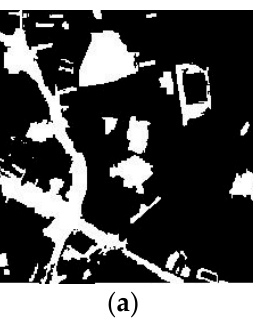
Figure 13. Change detection maps resulting from: ( a ) Otsu’s thresholding method, ( b ) threshold selection by clustering gray levels of boundary, and ( c ) k -means clustering ( k = 2), compared with ( d ) the reference image, with L2 as the basis image in the second study area (scale = 50).